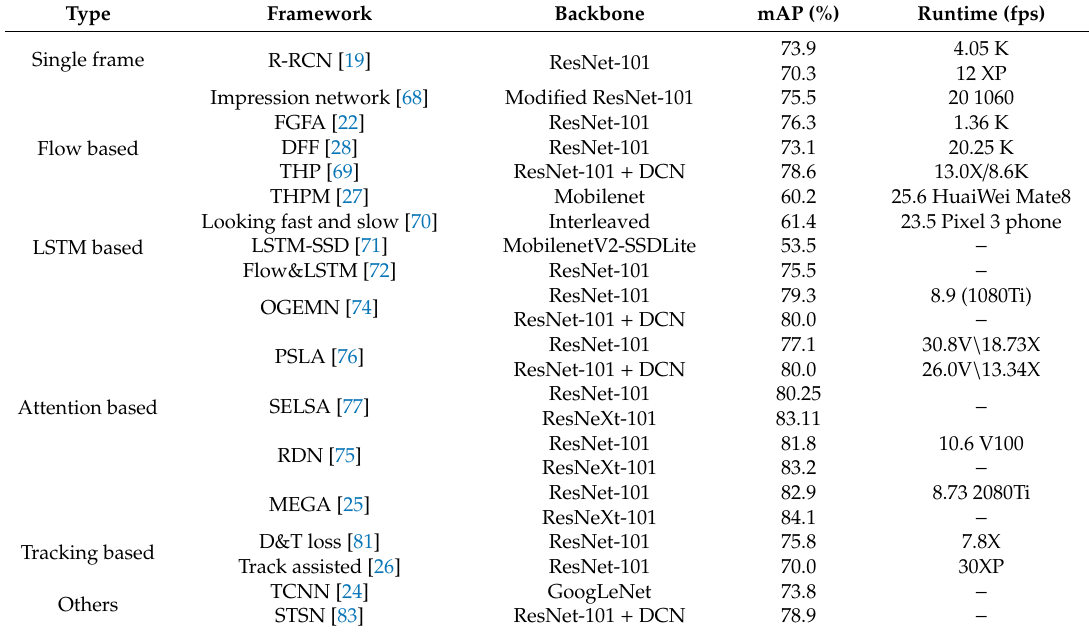
Table 4. Comparison among the video object detection methods without post processing; note that the runtime is based on the NVIDIA GPU used in the references: K means K40, XP means Titan XP, X means Titan X, V means Titan V, 1060 means GeForce GTX 1060, 1080 Ti means GeForce GTX 1080 Ti, 2080 Ti means GeForce GTX 2080 Ti.